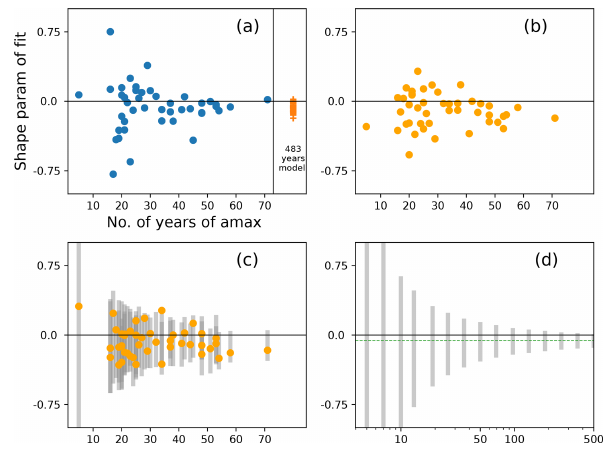
Figure C2. The uncertainty (variance) in different return levels is partitioned into contributions from uncertainty in the shape param- eter, uncertainty in the scale parameter, and a negative contribution from the covariance of these two parameters, shown as an offset to the base of the bars. Uncertainty in the shape parameter becomes dominant at long return